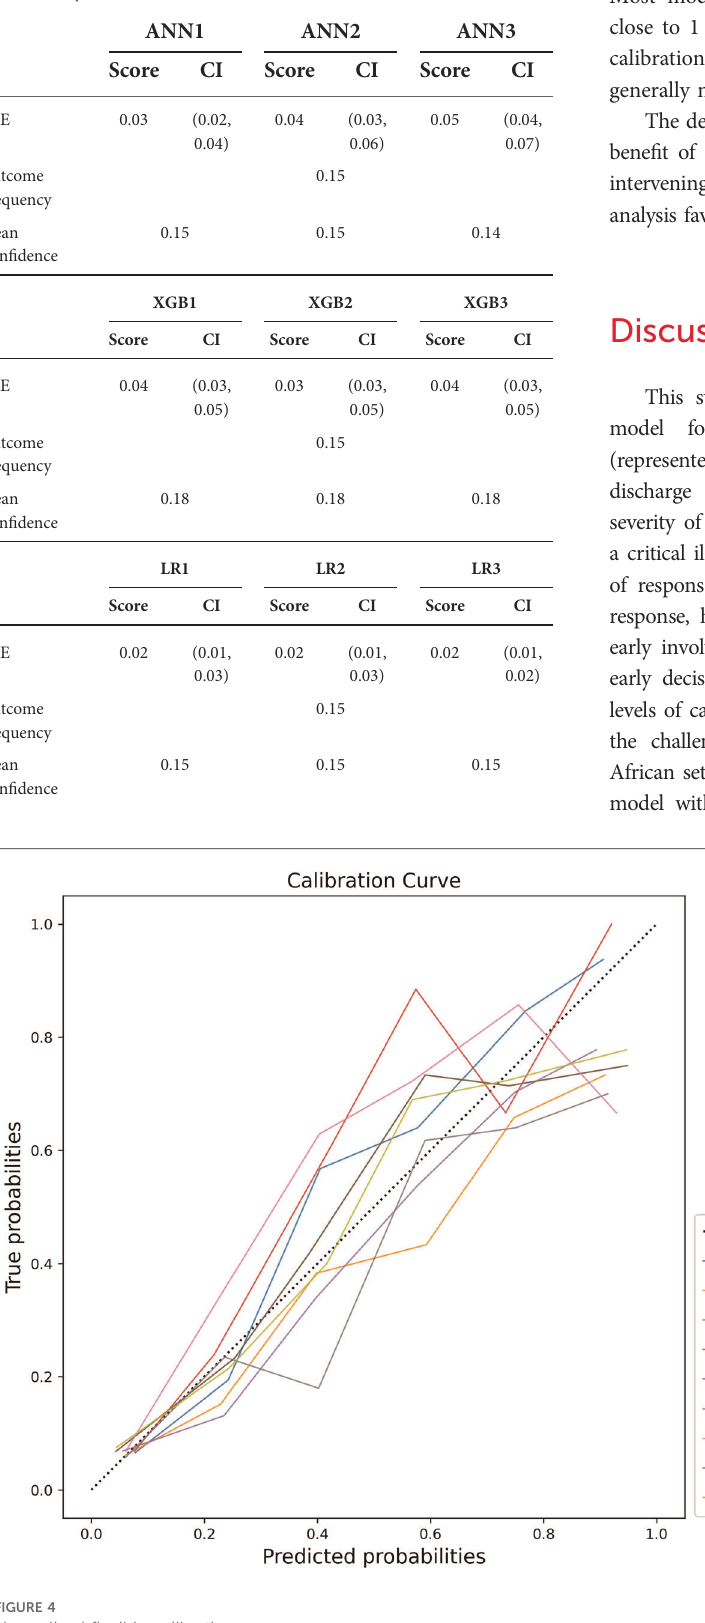
TABLE 6 Expected calibration error(ECE) and mean con fi dences.